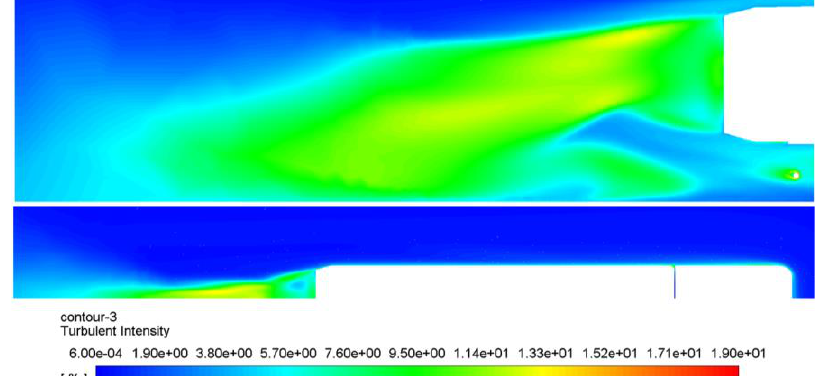
Fig. 23. Side view (top) and plan view (bottom) of the airflow turbulent intensity over Concept Two – Revision D.